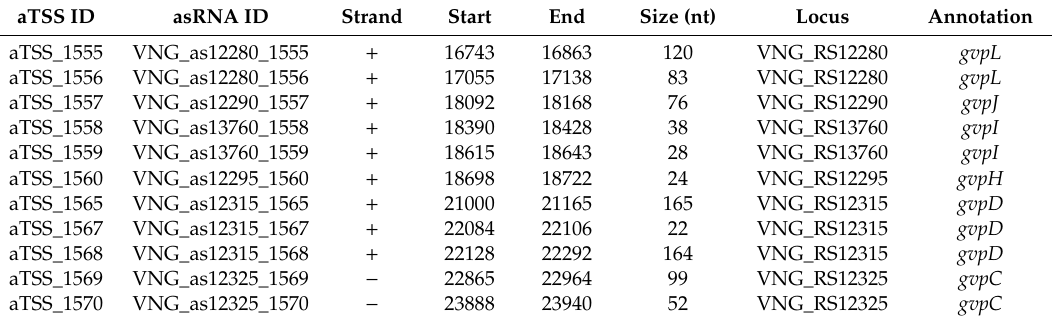
Table 1. asRNAs in gvp gene cluster, located in pNRC100. (nt: Nucleotide).